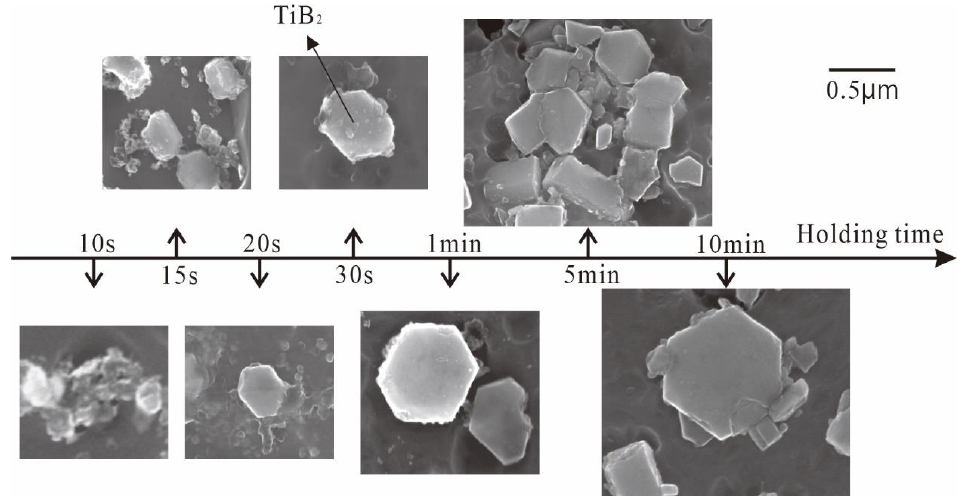
◦ C for different reaction times.